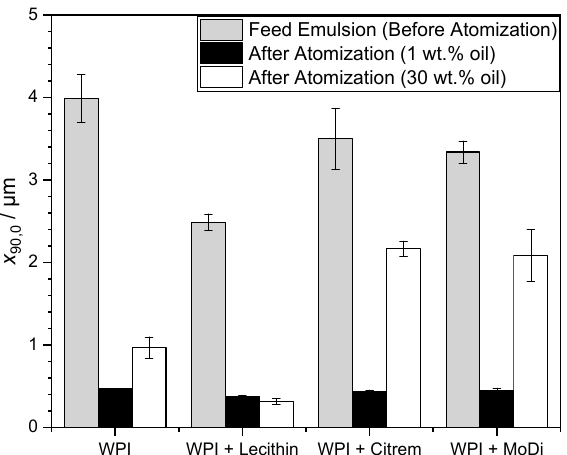
Figure 4. Summary of the mean x 90 diameters of oil droplet size of feed and atomized emulsions with different emulsifier systems and oil contents. Error bars correspond to standard deviations of three independent atomization experiments.